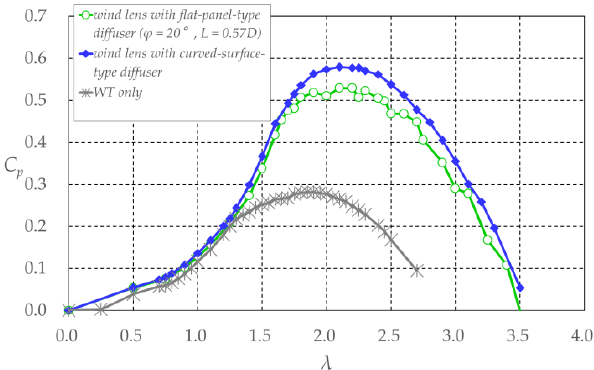
Figure 12. Power coefficient C p of wind turbines with and without a wind lens vs. tip speed ratio λ (curved-surface-type diffuser with flange width: h = 0.25 D m). Refer to Figure 2 for h , D , and L .